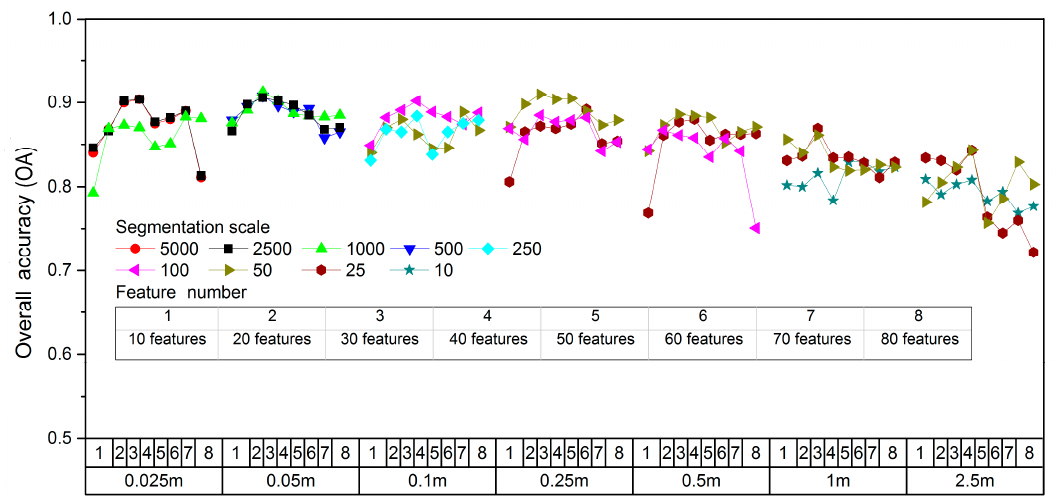
Figure 7. Overall accuracy (OA) of multi-scale images with di ff erent segmentation scales and feature